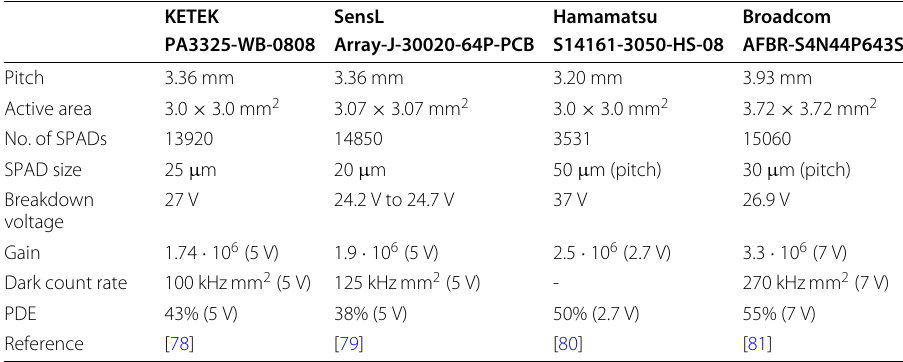
Table 1 Characteristics of the investigated analog SiPM types. Parameters are taken from the respective data